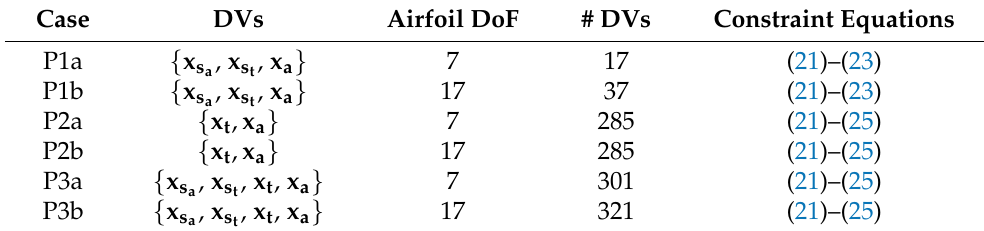
Table 6. Optimization problem labels. Problems 2 and 3 are only solved with aeroelastic models rather than rigid as well, as they include structural sizing and stress